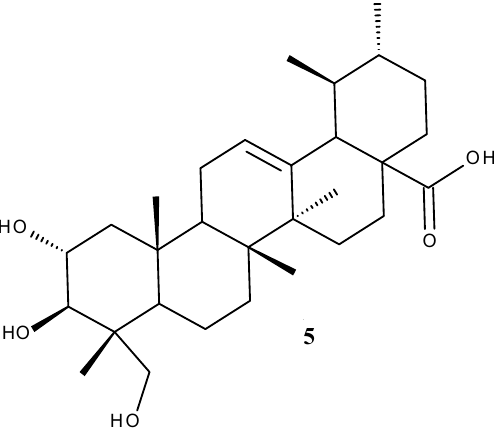
Figure 3. The chemical structure of asiatic acid ( 5 ).